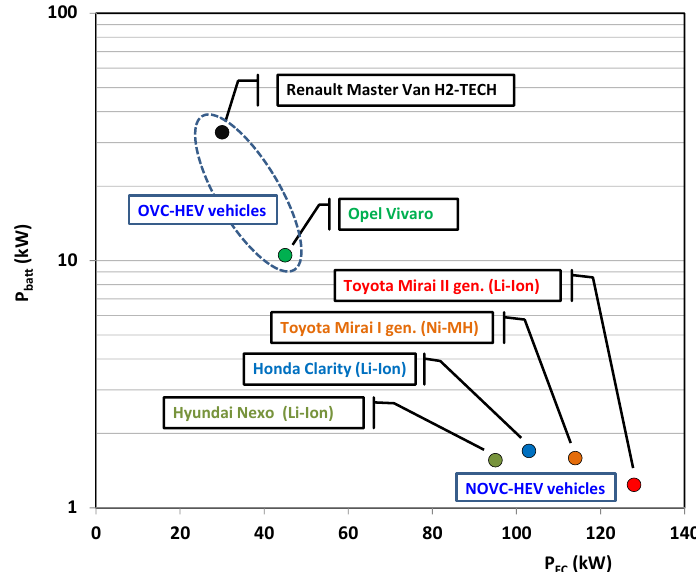
Figure 3. Comparison of cell power vs. high voltage battery capacity [10,13–15].